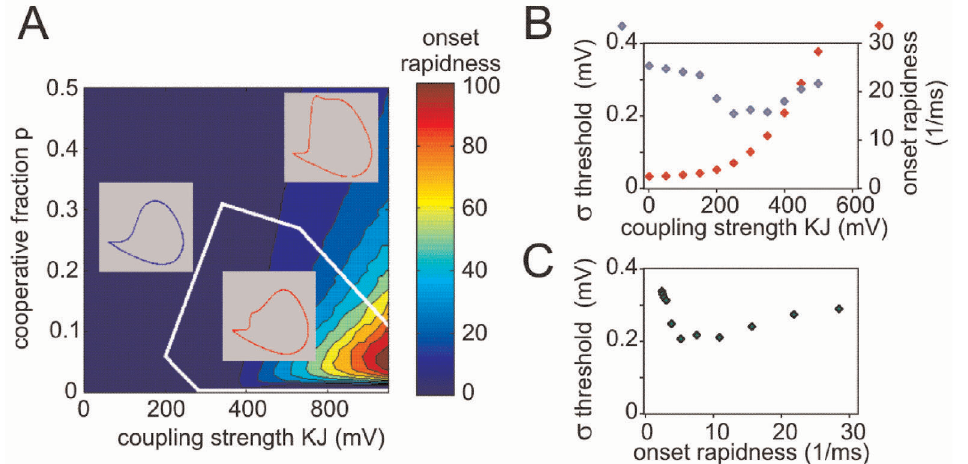
Figure 4. AP onset rapidness and threshold variability in models with cooperative channels. ( A ) Dependence of the AP onset rapidness measured as the phase slope at d V = d t ~ 25 V = s on the coupling strength and the fraction of cooperative channels. White contours delimit the bounder lines between the monophasic and the biphasic APs (see insets). ( B ) Dependence of the threshold variability (blue symbols, scale on the left) and onset rapidness (red symbols, scale on the right) on the coupling strength KJ for a model with a small fraction ( p ~ 10% ) of cooperative channels. Fluctuating current for injection that mimicked background synaptic noise was synthesized as described in Methods (see Eq. 3) ( C ) Relation between threshold variability and AP onset rapidness for the same model, data from ( B